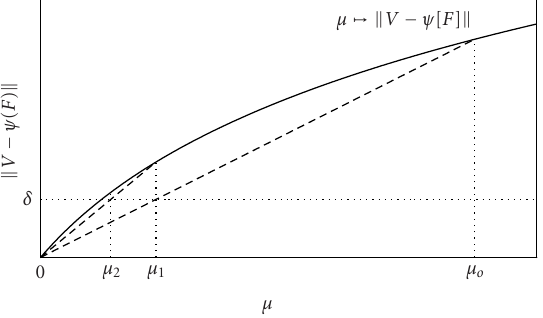
Figure 6.1. Iterative search of the regularization parameter µ that fits the Morozov discrepancy prin-